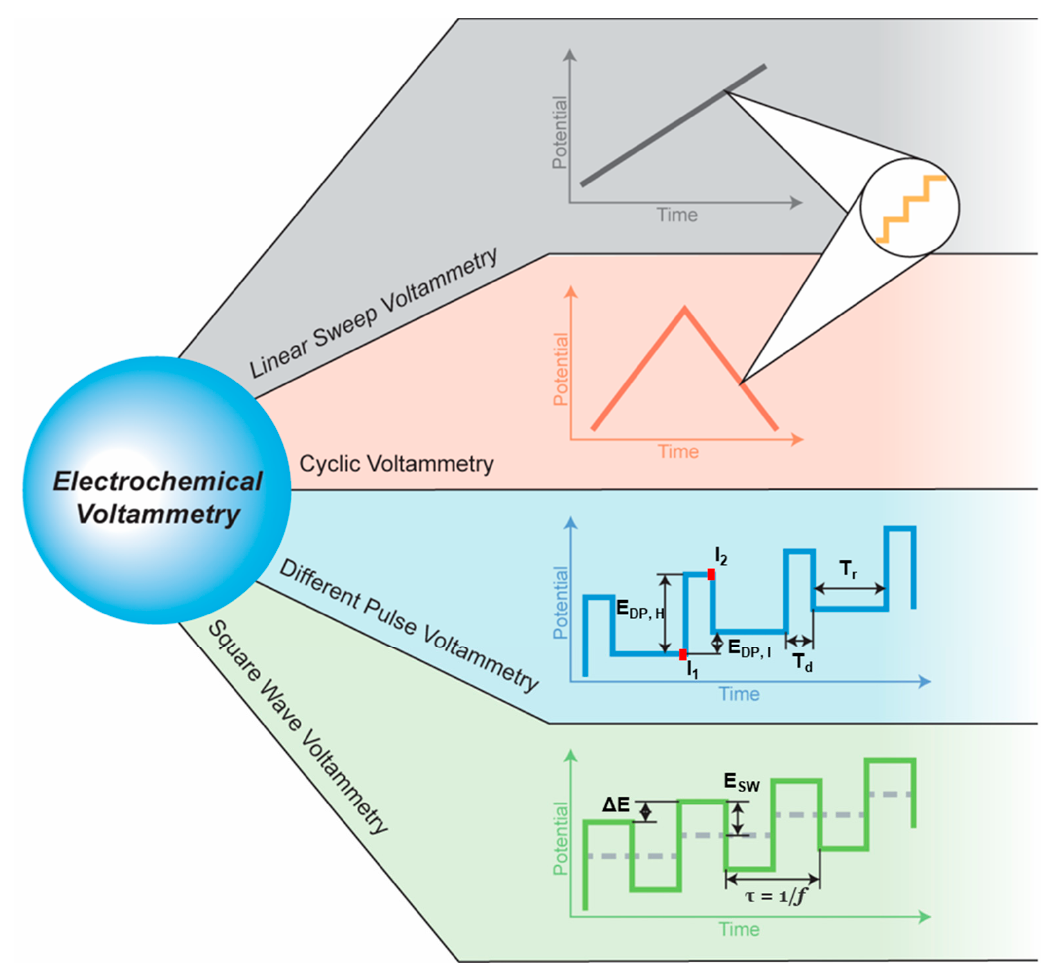
Figure 9. Electrochemical voltammetry and measurement methods. Table 1. Carbon material, their variation and performance in detecting application.